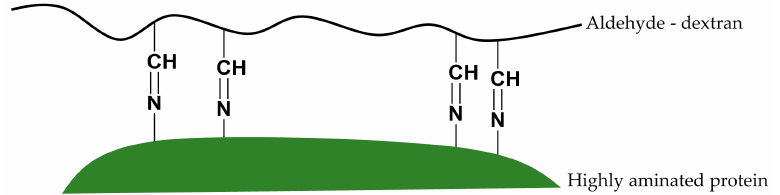
Figure 8. Intramolecular two-point cross-linking between freshly prepared aldehyde-dextran and highly aminated enzyme surfaces.